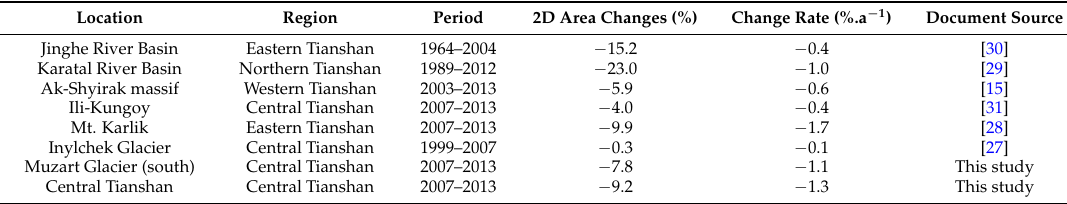
Table 3. The glaciers 2D area changes reported from different studies in Tianshan Mountains. Location Region Period 2D Area Changes (%) Change Rate (%.a − 1 ) Document